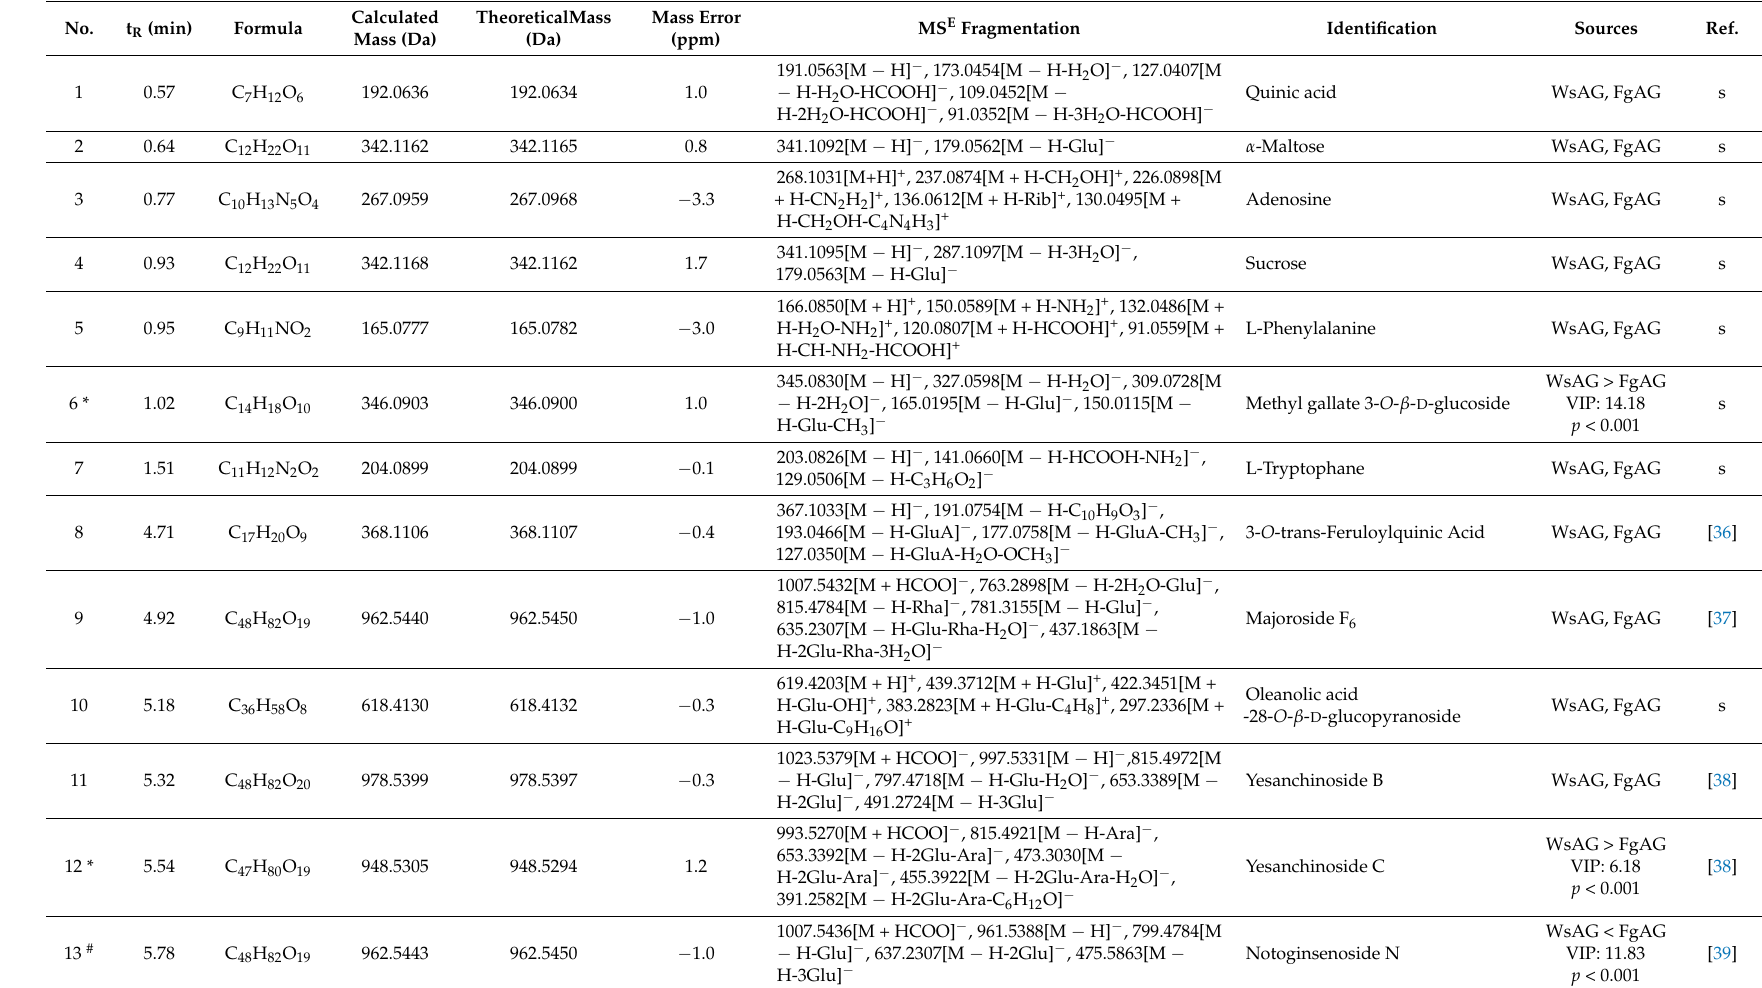
Table 1. Compounds identified from FgAG and WsAG by UPLC-QTOF-MS E